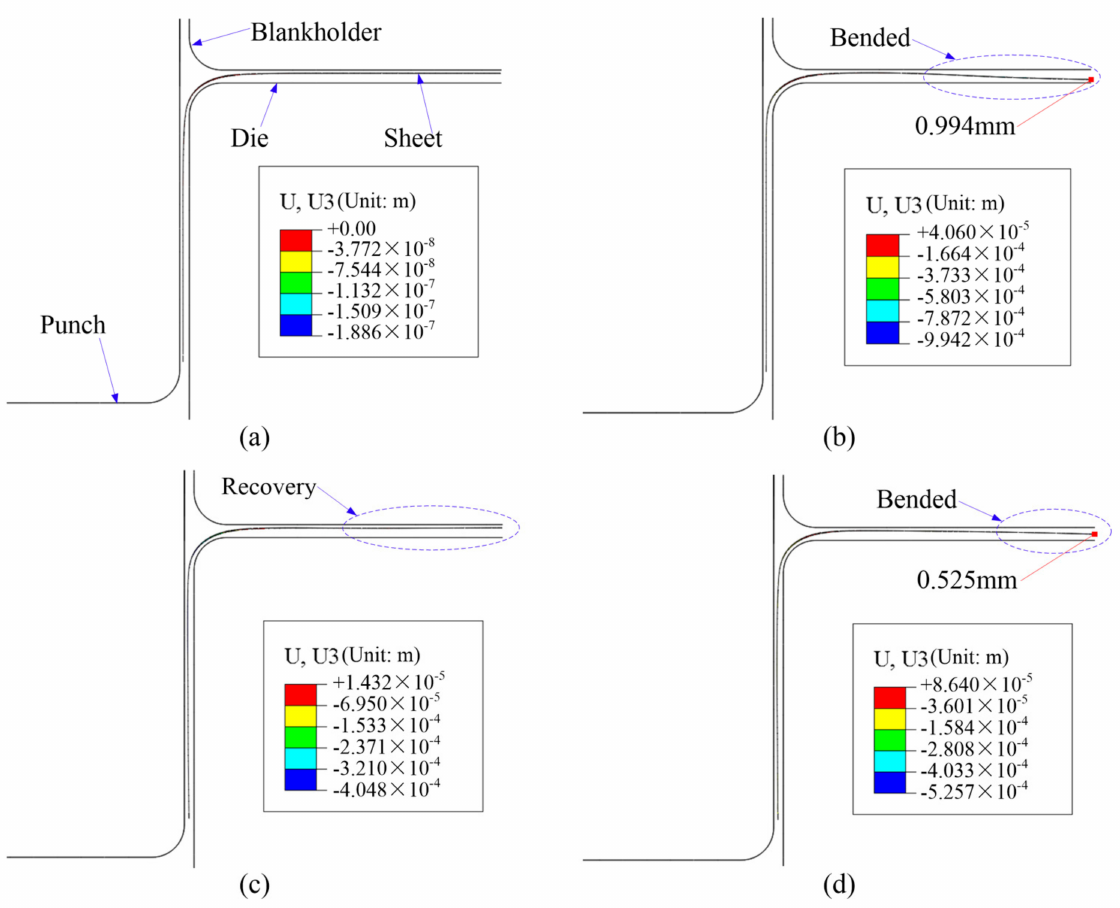
Figure 12. Deformation profiles after a 7-kV discharge at ( a ) 0 µ s, ( b ) 200 µ s, ( c ) 600 µ s, and ( d ) 1000 µ